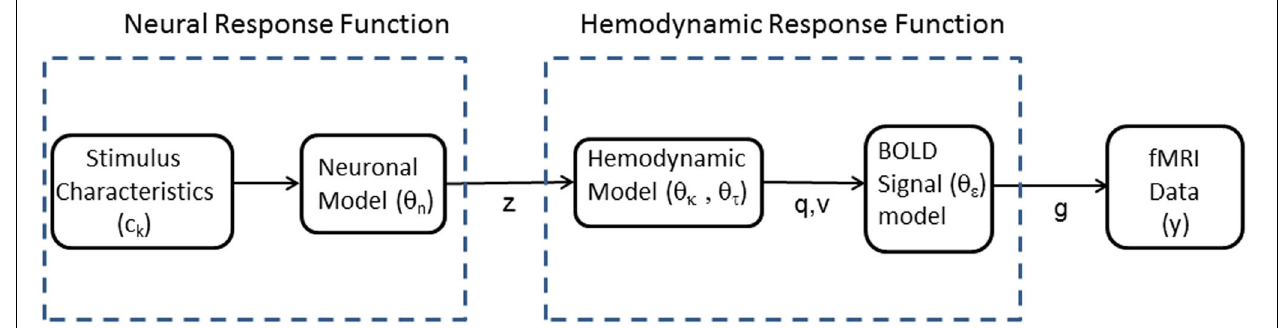
parameters θ n . The HRF relates predicted fMRI activity g to neuronal activity z via blood deoxyhemoglobin q and volume v variables. These relations are specified by an extended Balloon model with unknown parameters θ h = { θ κ ,θ τ ,θ (cid:5) } describing the rate of signal decay, transit time, and ratio of intra- to extra-vascular signal, respectively. The model is fitted to fMRI data, y , so as to estimate the unknown parameters θ n and θ h